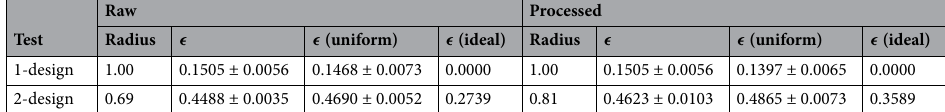
Table 7. Summary of test results for the ensemble of unitaries generated using the ibmq_sydney quantum processor. ‘Raw’ shows the results without quantum readout error mitigation. ‘Processed’ shows the results with quantum readout error mitigation. ‘Radius’ is the truncation radius considered for a test. The column with ‘uniform’ shows the values of ǫ obtained when replacing the experimentally determined relative frequencies with uniform probabilities. The column with ‘ideal’ shows the expected values of ǫ for the approximate 2-design for the truncation radii considered.